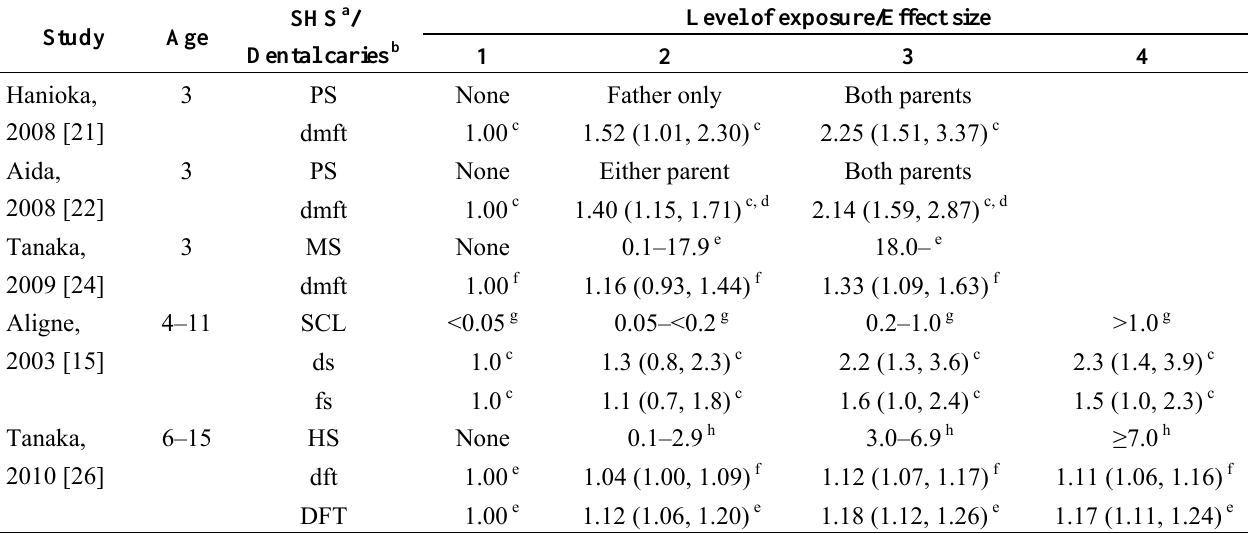
Table 6. Dose - response relationships between SHS exposure and dental